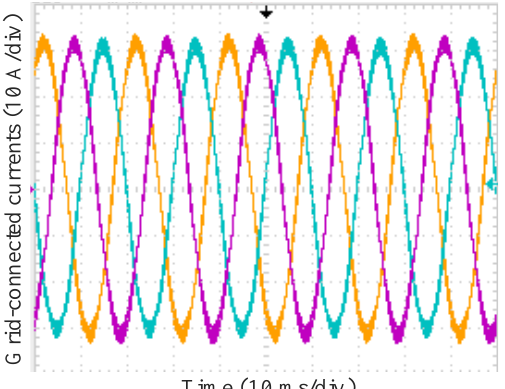
Figure 22. Current waveform of a VSG with an inner regulator.